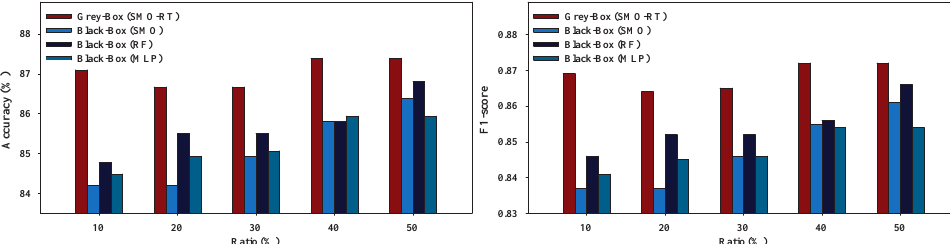
Figure 11. Box-plot with performance evaluation of Grey-Box and Black-Box models for Australian dataset.